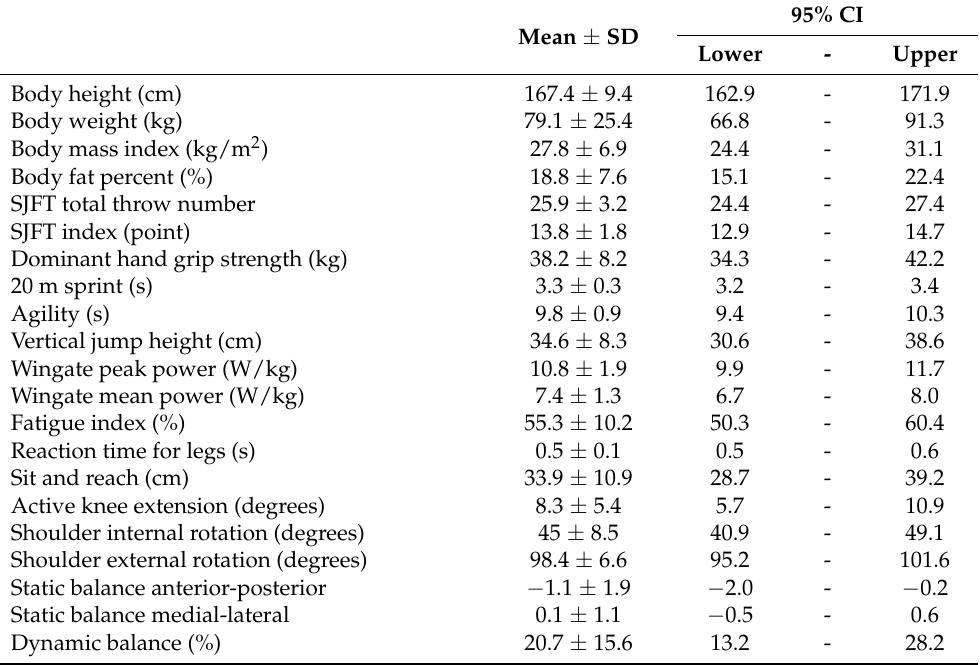
Table 1. Judo athletes’ physical characteristics and exercise tests